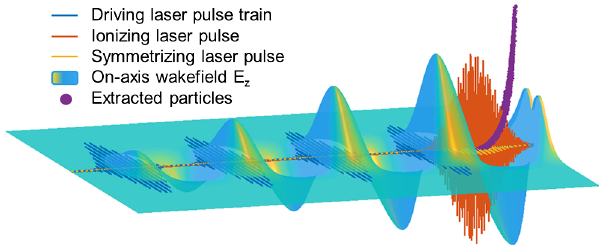
FIG. 6. The three-laser system of the resonant multipulse injection and acceleration technique